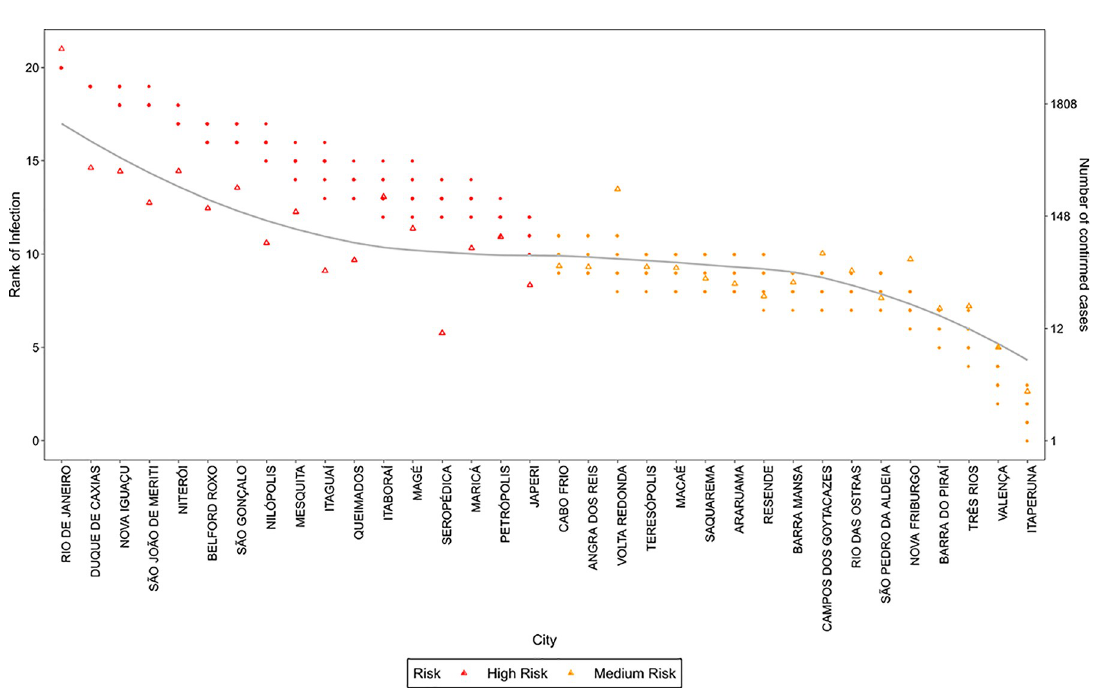
Fig 15. Rank of infection and number of confirmed COVID19 cases for Rio de Janeiro state. The points refer to ranks estimated for different values of s , the triangles refer to the official number of confirmed COVID19 cases registered on the 1 st of May 2020 for each city in the state of Rio de Janeiro. The line is a smooth approximation of the confirmed cases (triangles). The colors refer to the risk evaluated by k-means clustering of the ranks attributed by the simulated models.